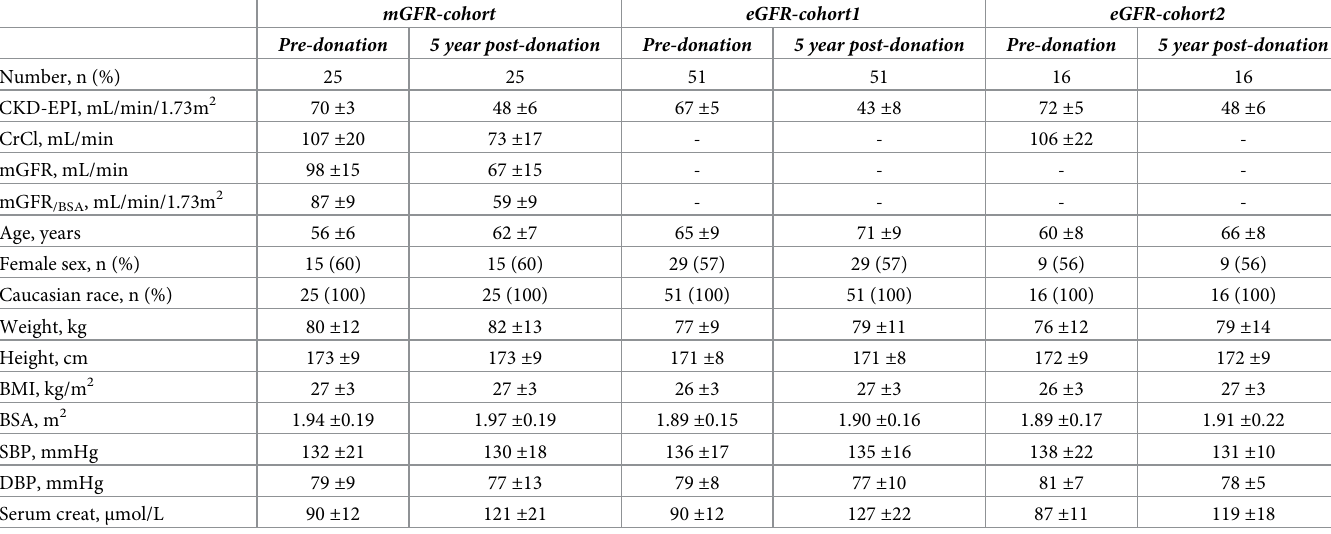
Table 4. Pre- and 5 year post-donation characteristics of 10% of the donors with lowest pre-donation eGFR per